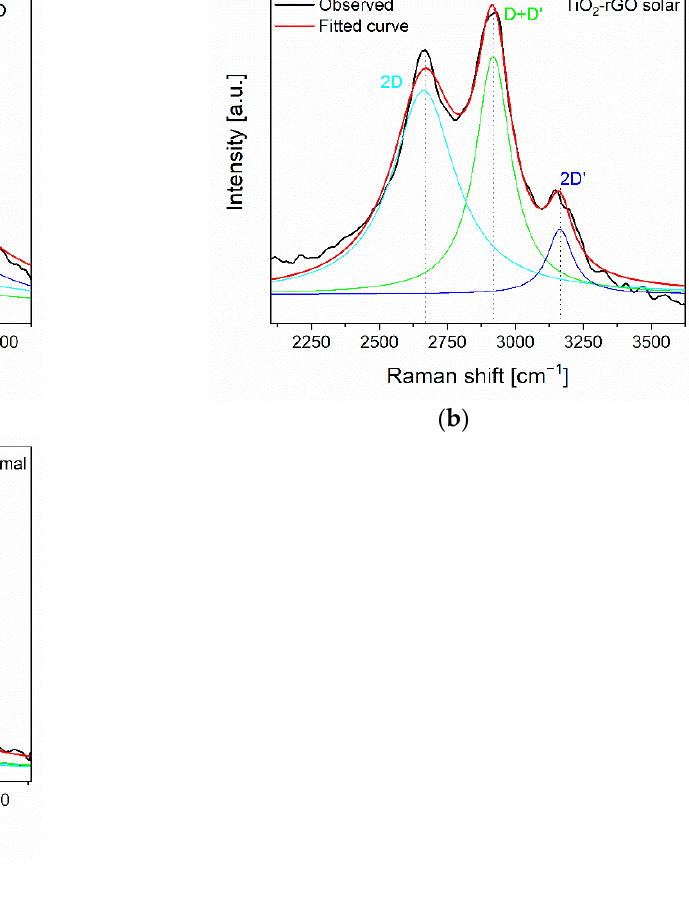
Figure 5. Second-order Raman signals for TiO 2 -GO ( a ), TiO 2 -rGO solar ( b ) and TiO 2 -rGO thermal ( c ). The spectra are acquired with an excitation wavelength of 532 nm.